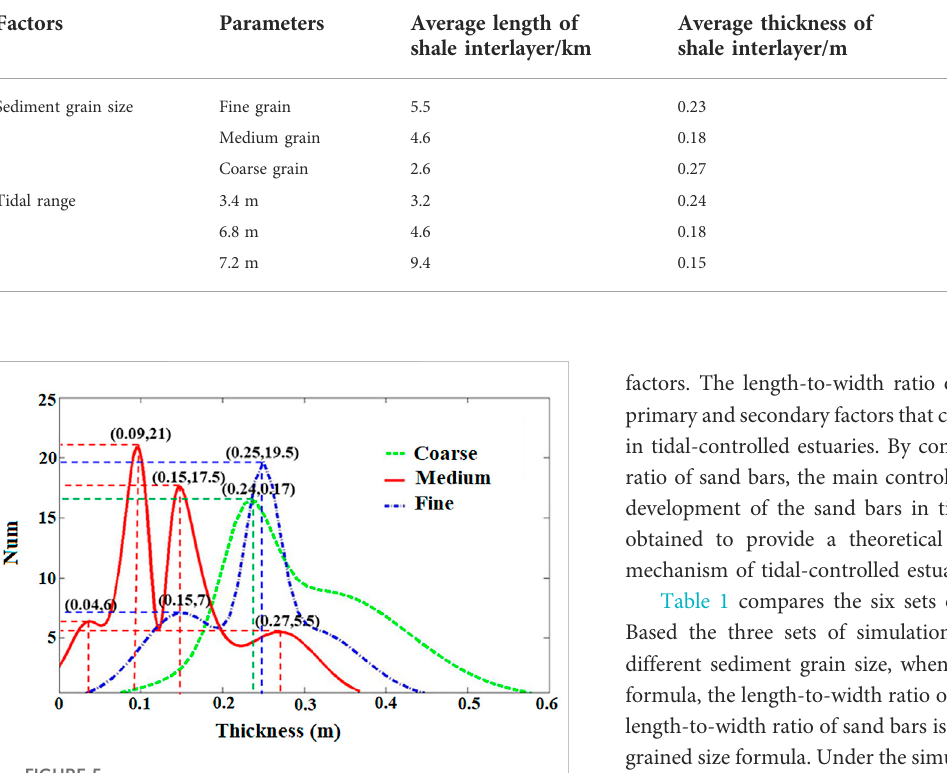
TABLE 2 Quantitative comparison of shale interlayer shapes in tidal bars under various factors in tidal-controlled estuaries.